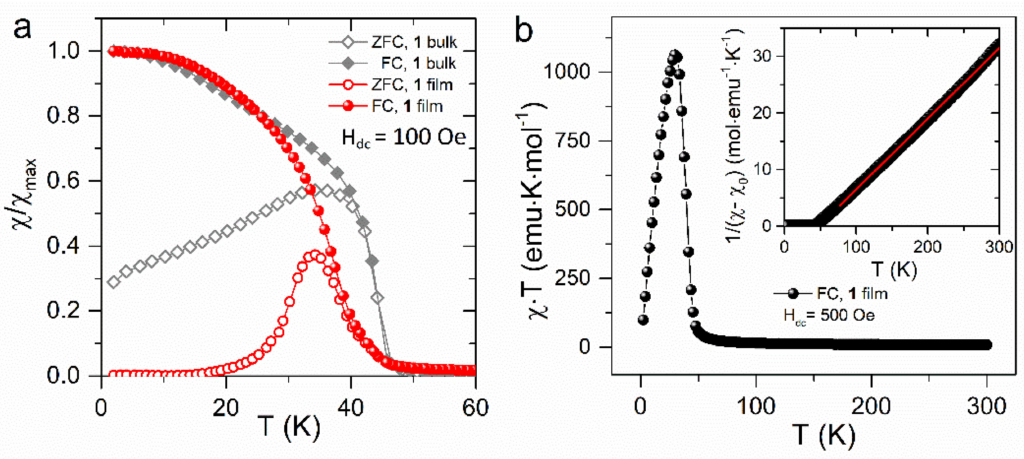
Figure 7. ( a ) Thermal variation of the DC susceptibility measured for (1) film and (1) bulk under zero field cooled (ZFC) and field cooled (FC) conditions in the applied field of 100 Oe; ( b ) Temperature dependence of χ · T for (1) film. Inset, thermal variation of the reciprocal magnetic